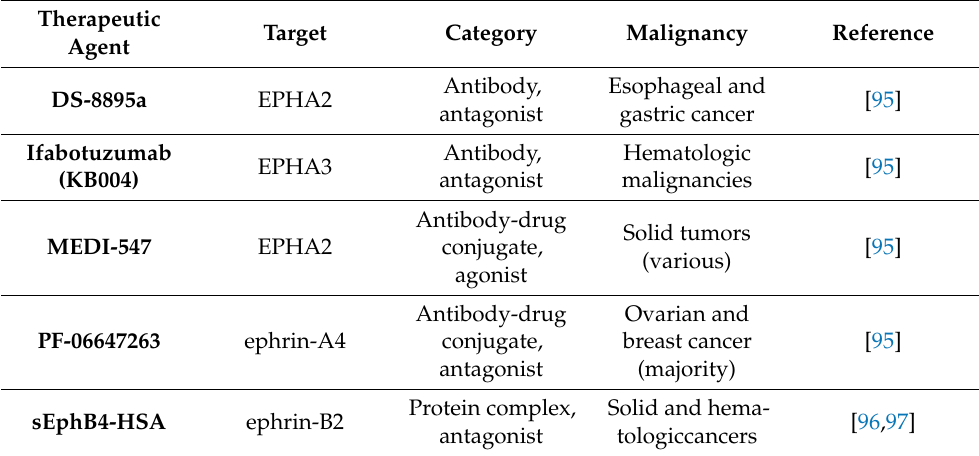
Table 7. Agents (bold) targeting EPHs/ephrins tested in clinical